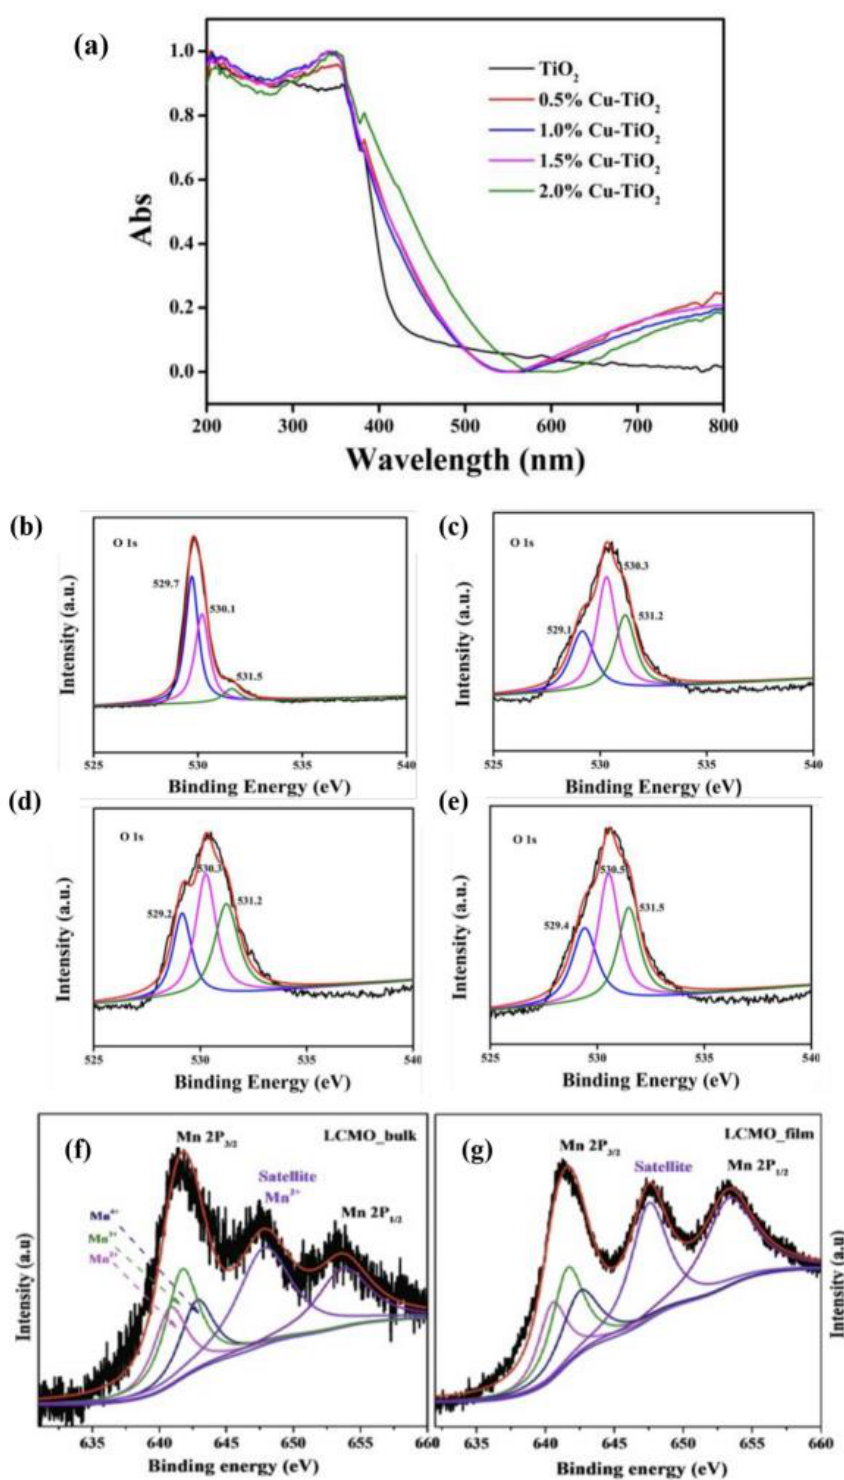
Figure 3. ( a ) UV-vis diffuse reflectance spectra of TiO 2 samples with different Cu loadings, XPS spectra of O 1s on the surface of ( b ) TiO 2 , ( c ) 0.5% Cu-doped TiO 2 , ( d ) 1.5% Cu-TiO 2 , and ( e ) 2.0% Cu-doped TiO 2 samples, and XPS spectra of Mn 2p core level of ( f ) LCMO bulk and ( g ) LCMO film [91,92].